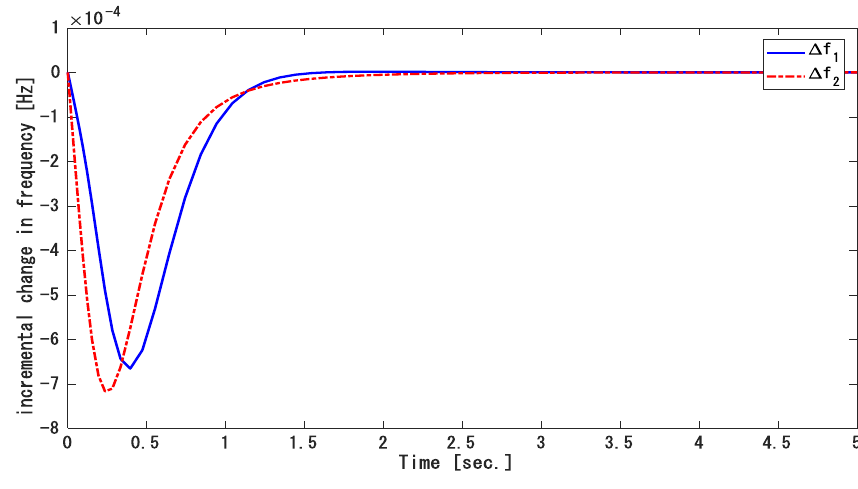
Figure 2. The tie-line variation is illustrated in Figure 3. The control input signal for area one and two are given in Figure 4.